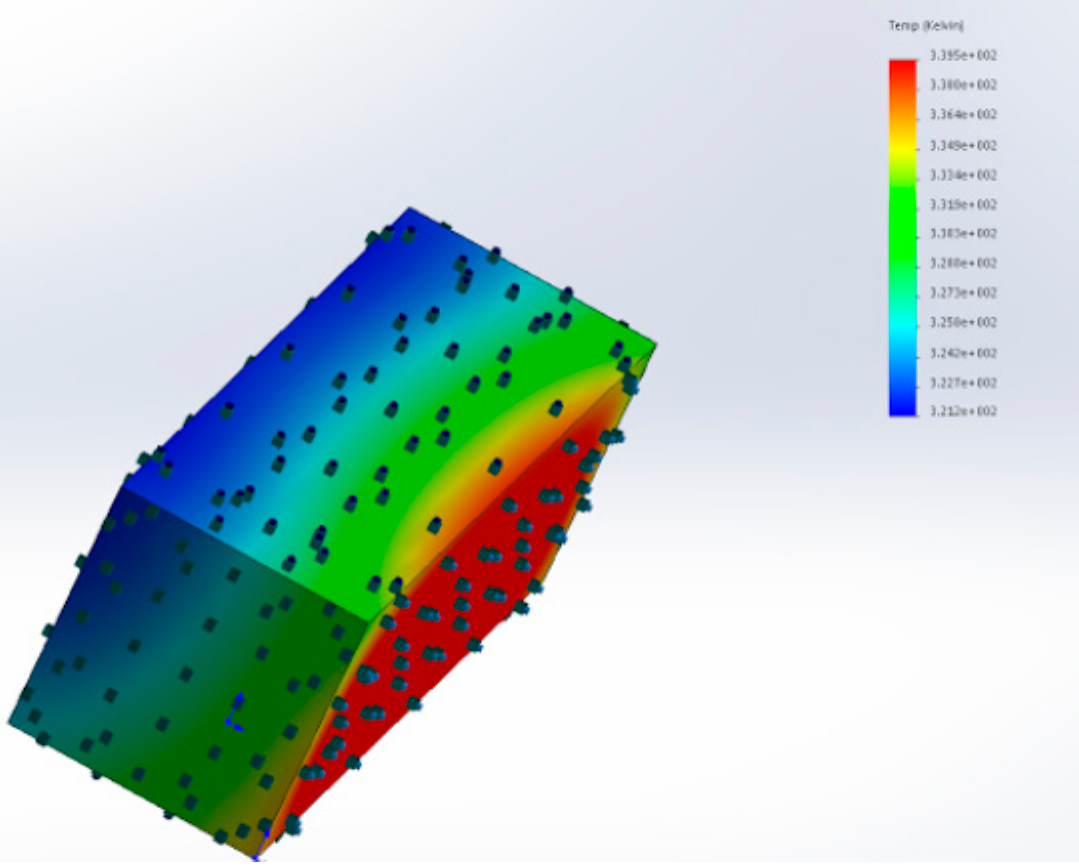
Figure 58. Hot-case Temperature Gradient with Power Dissipation of 0.7995 W.